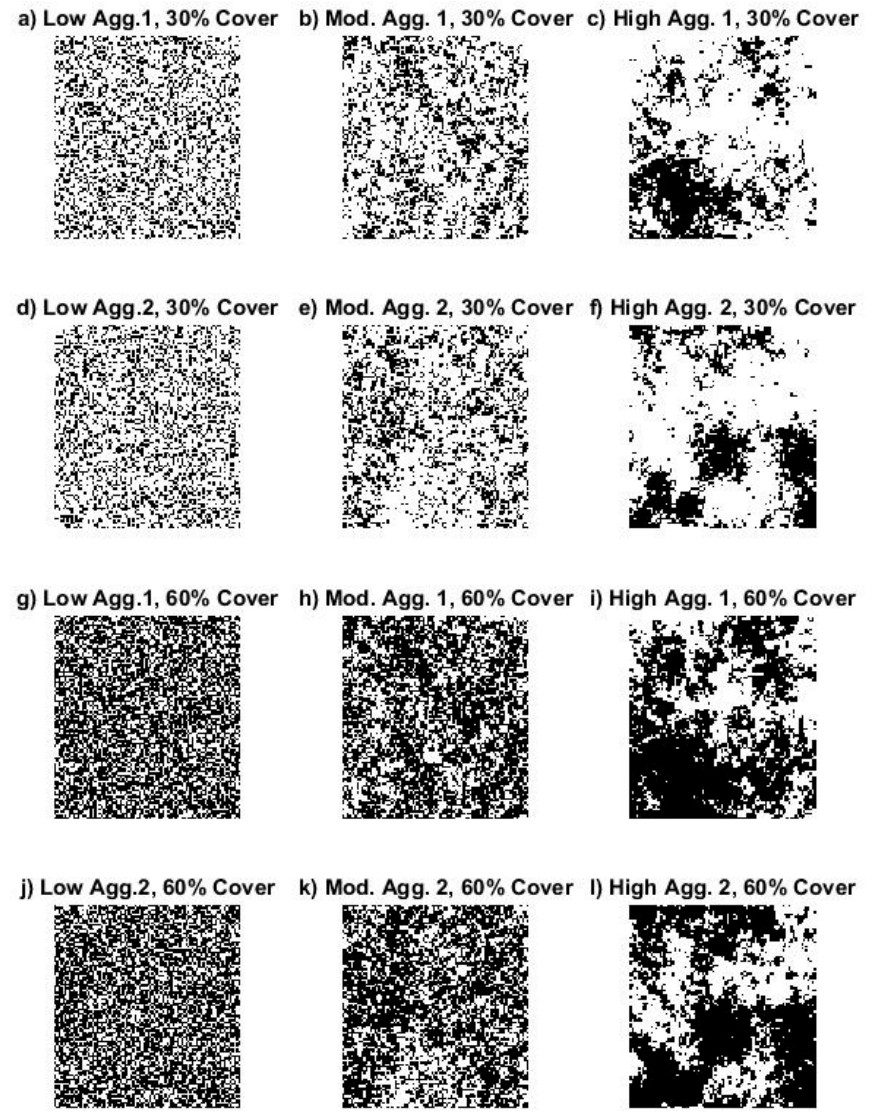
Figure 2. Synthetic coupled fuel spatial patterns generated with a 1/f noise process to represent heterogeneity in forest cover and pattern. Square areas are the central portions of the simulation domain, called the vegetation modification zone (VMZ). Vegetation patterns on either side of the VMZ were identical for all simulations for a given canopy cover case. Black cells represent forest with litter surface fuels, while white cells represent open areas with grass surface fuels. Rows from top to bottom show spatial patterns with increasing aggregation (top: low, middle: moderate, bottom: high). Within each row there are two spatial replicates, 1 and 2, each with 60% and 30% canopy cover cases; 30% canopy cover cases are derived from corresponding 60% canopy cover cases.